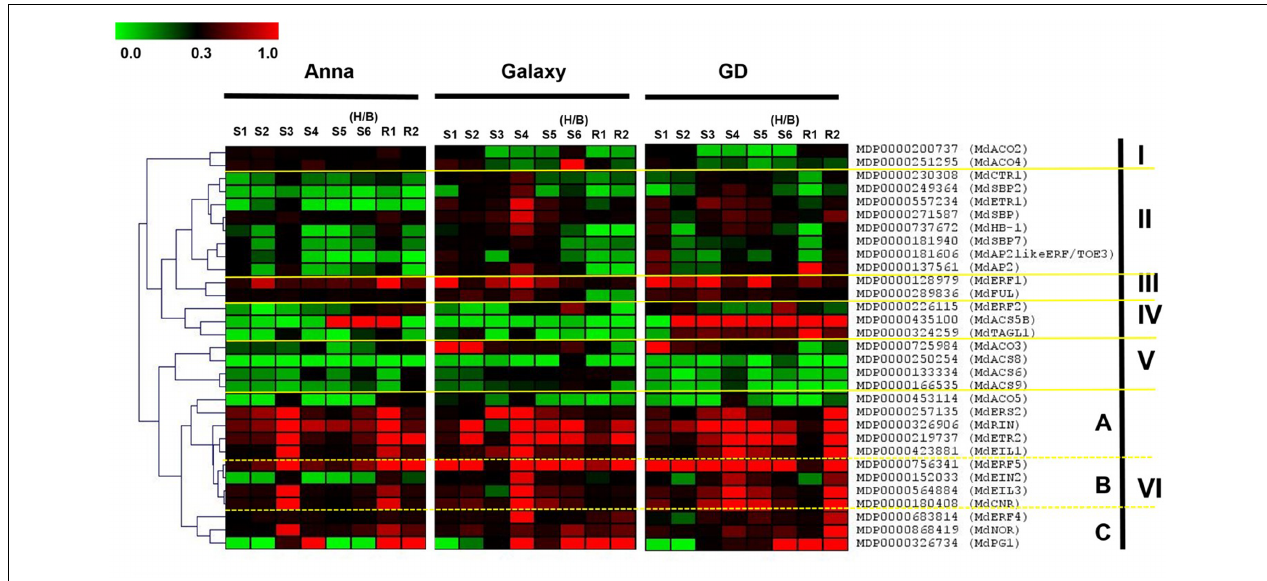
FIGURE 8 | Heat map of the expression profile of genes involved in ethylene biosynthesis, ethylene response pathway, and developmental regulators, at different stage of fruit development (S1–S6/H/B) and at storage (R1–R2). The hierarchical clustering of genes is based on the Spearman correlation, which allows genes clustering according to their expression pattern and levels. Relative expression of the targeted genes are expressed by 2 − (cid:49) C t method, considering expression in relation to HKG (actin). The green and red color corresponds to low and high expression,